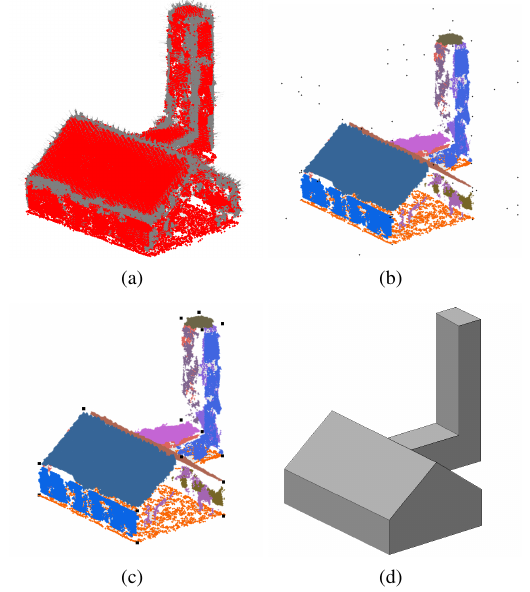
Figure 2. Voxel-based building reconstruction (a) Grid cell planes (b) Vertices from intersecting all planes (c) Condensed vertices (d) Polygonal building hull with modeled discontinuities